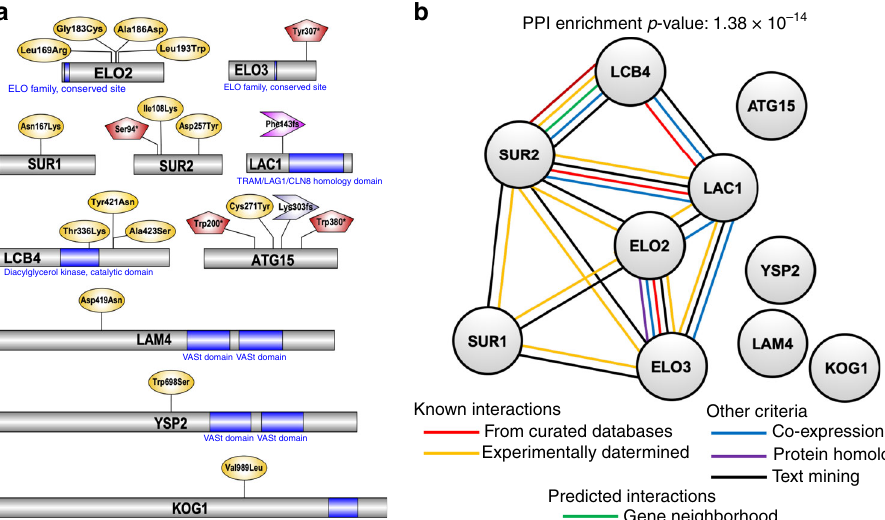
Fig. 1 GNF179-resistant yeast strains harbor mutations in endoplasmic reticulum(ER)-based lipid homeostasis and autophagy genes. a Protein maps showing relevant mutations and PROSITE predicted protein domains, if applicable. Maps were generated using Illustrator of Biological Sequences (IBS) software package 86 . Missense mutations are shown in yellow ovals, nonsense mutations in red pentagons, and frameshift mutations as purple arrows. b Protein – protein interaction (PPI) network was generated using the STRING database 87 . Each node represents a S. cerevisiae protein and connecting lines delineate interactions. The PPI enrichment p -value ( p = 1.38 × 10 − 14 ) indicates that the proteins show signi fi cantly more interactions among themselves than would be expected from a random subset of genes from the yeast genome.